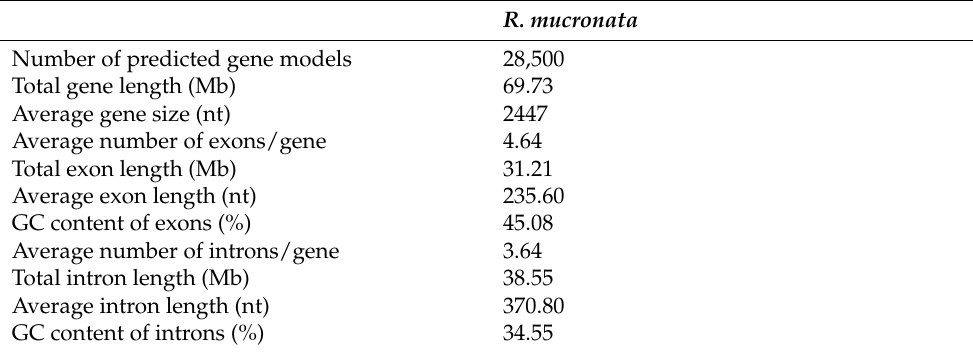
Table 2. R. mucronata genome annotation